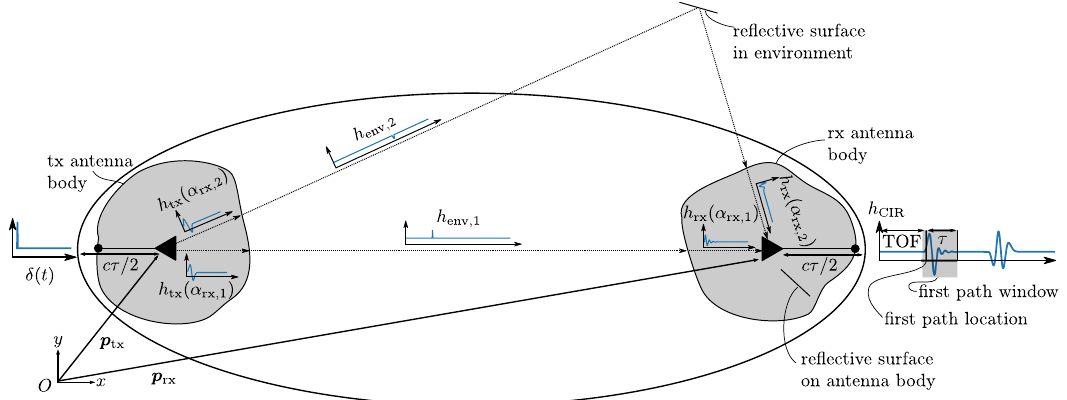
Figure 1. Composition of an example channel impulse response (CIR) for a propagation channel with one direct and indirect path and an angle of arrival (AOA)-dependent antenna impulse response function as given in Equation (1). By considering only a window of the CIR around the first path location, multipath components resulting from reflections outside the ellipsoid as given in Equation (3) are